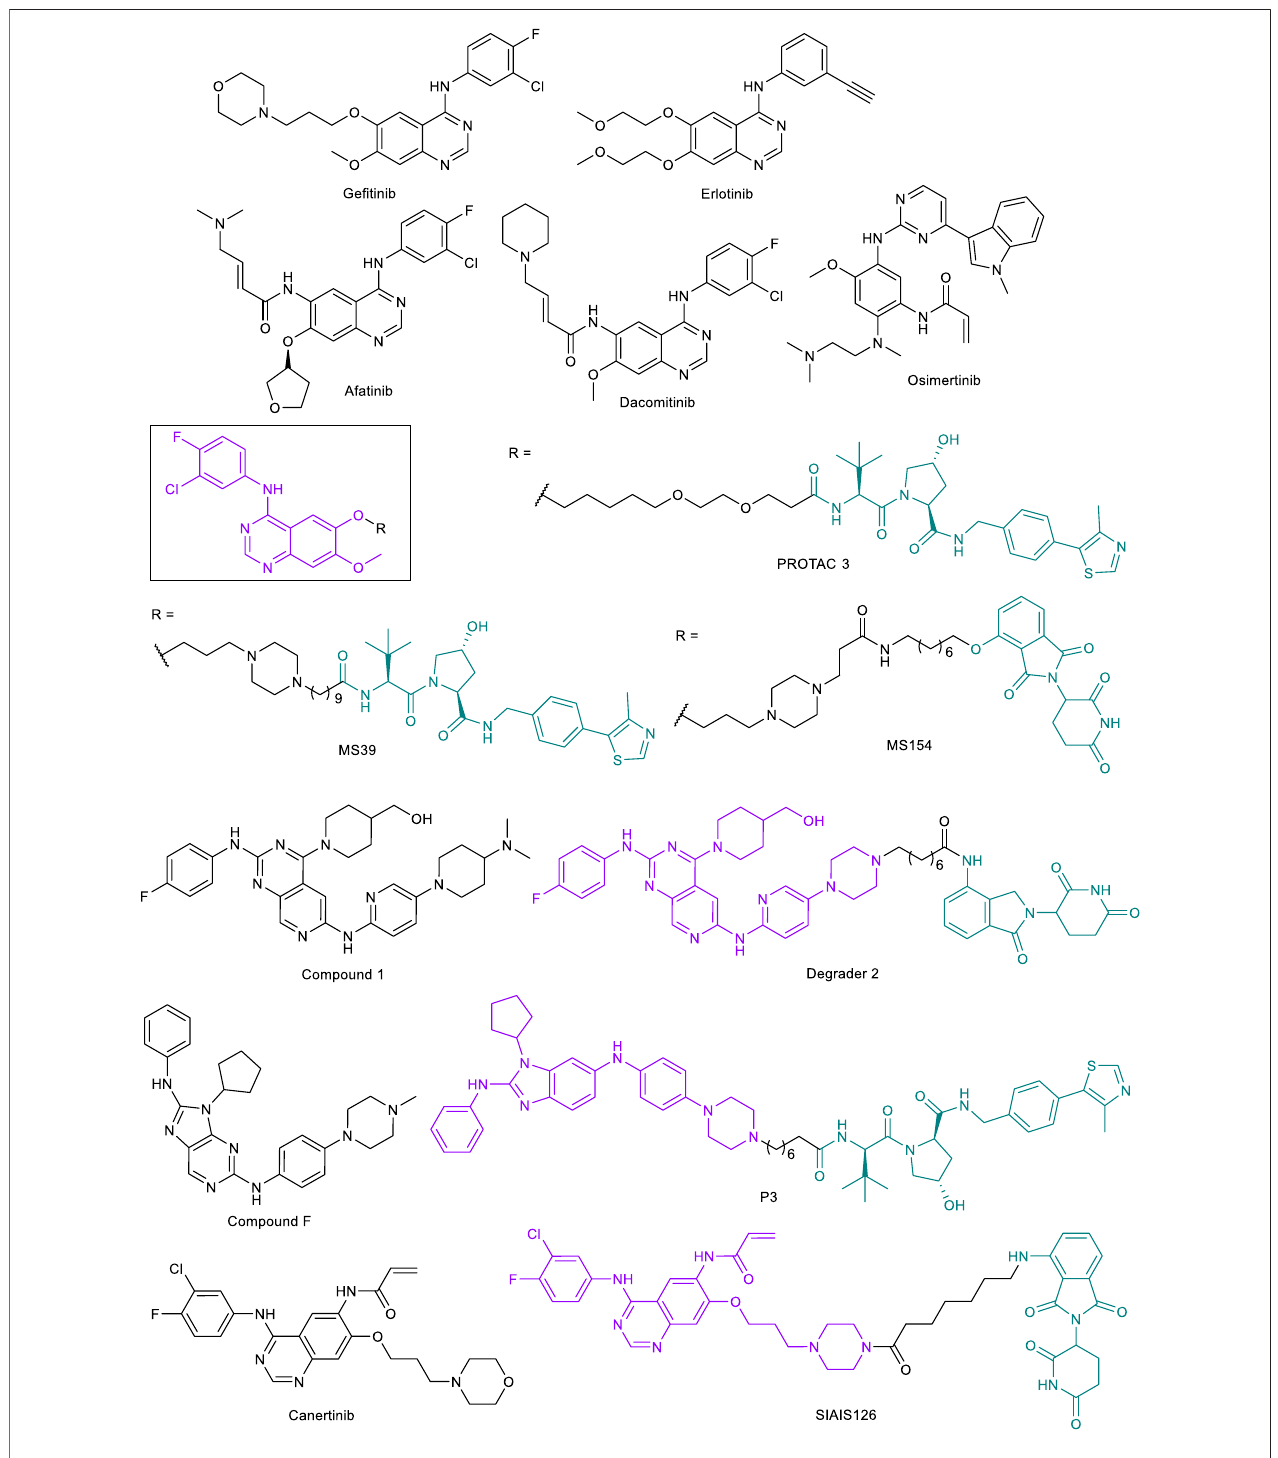
FIGURE 7 | Key EGFR small molecule inhibitors and EGFR-targeted PROTACs.